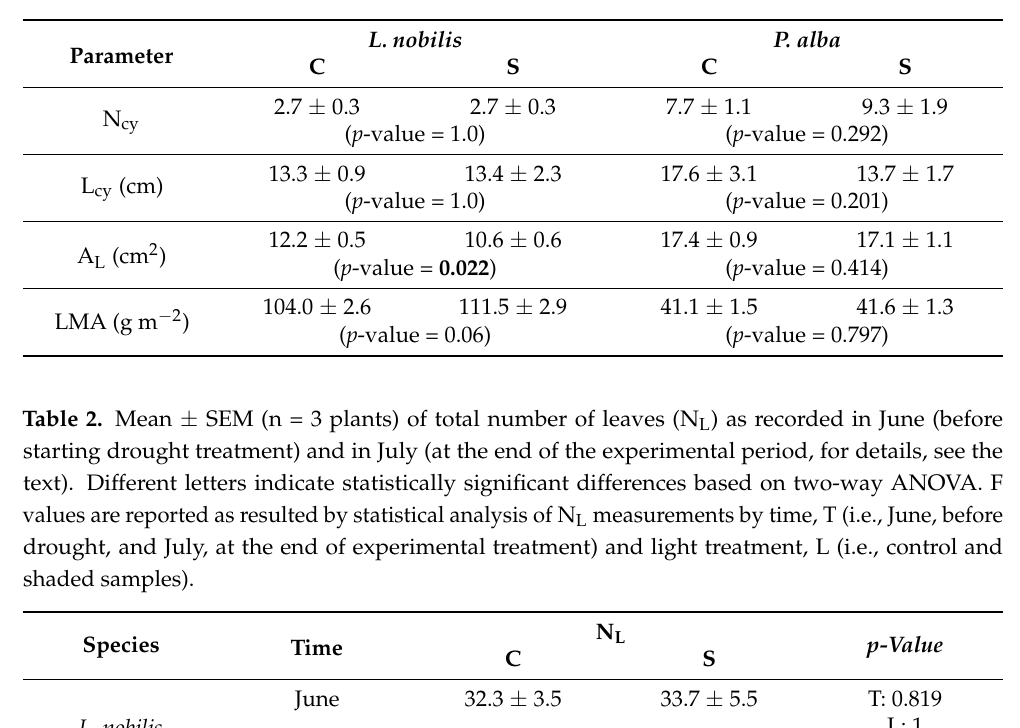
Table 1. Mean ± SEM of the total number (N cy ) and length (L cy ) of current-year branches, mean leaf surface area (A L ) and leaf mass per area (LMA) as recorded in control (C) and shaded (S) samples of L. nobilis and P. alba . Differences between C and S samples were checked by a Student’s t -test. p -Values are reported between brackets; n = 3 plants for N cy and L cy ; n = 40 leaf samples for A L and LMA.